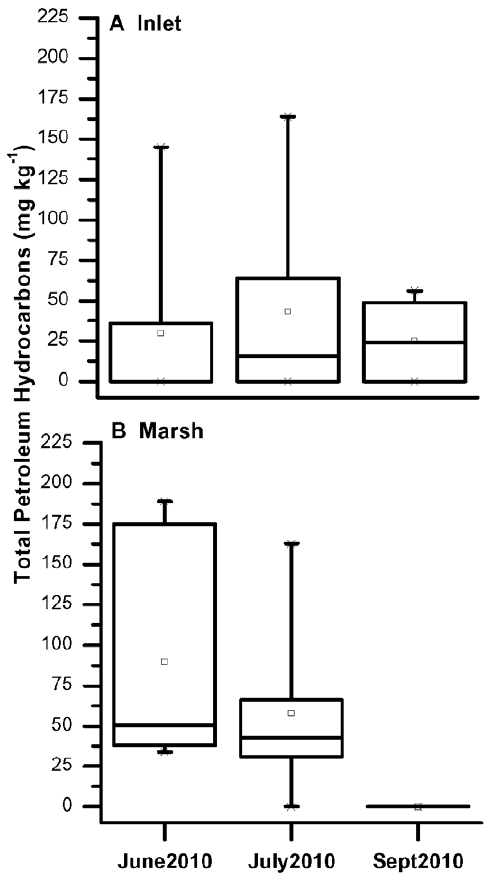
Figure 2. Boxplots of TPH concentrations in (a) Inlet and (b) Marsh surface and subsurface sediments. Each box represents the concentration range of 50% of the observations. Lines within the boxes represent the median values, open squares are the averages, and the whisker lines connect to outliers. doi:10.1371/journal.pone.0041305.g002 PLoS ONE |